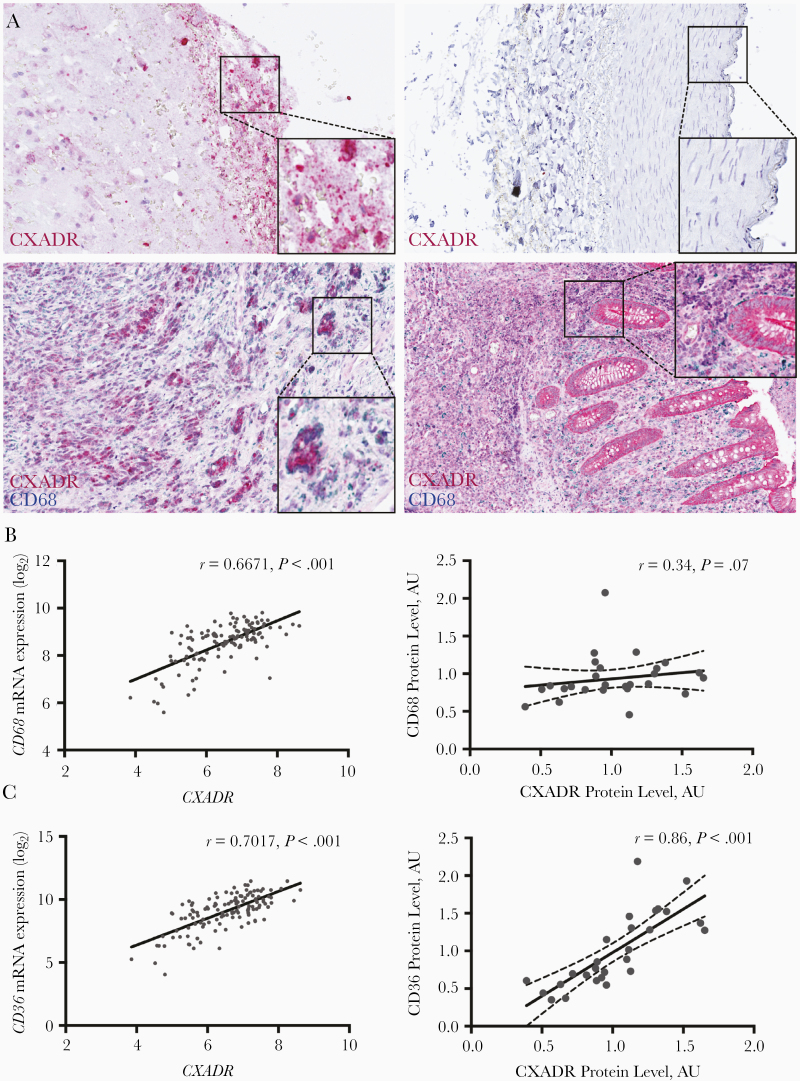
Immunohistochemical analysis of coxsackievirus and adenovirus receptor (CXADR) expression and localization in human carotid plaques. A, Sections of a carotid artery containing a plaque (upper and lower left), a normal artery (upper right), and the appendix (lower right) were stained with antibodies against CXADR (upper panels), or the combination of CXADR and CD68 (lower panels). B, C, Pearson correlation analysis showing the association between CXADR and CD68 (B) and between CXADR and CD36 (C) in human carotid plaques at messenger RNA (left) and protein (right) levels. Abbreviation: AU, arbitrary units.